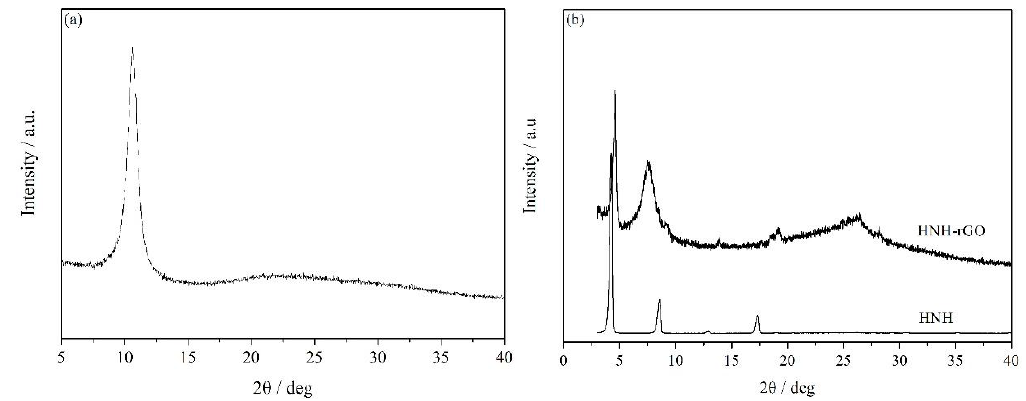
Figure 3. The X-ray diffraction (XRD) patterns of GO ( a ) and HNH-rGO ( b ).